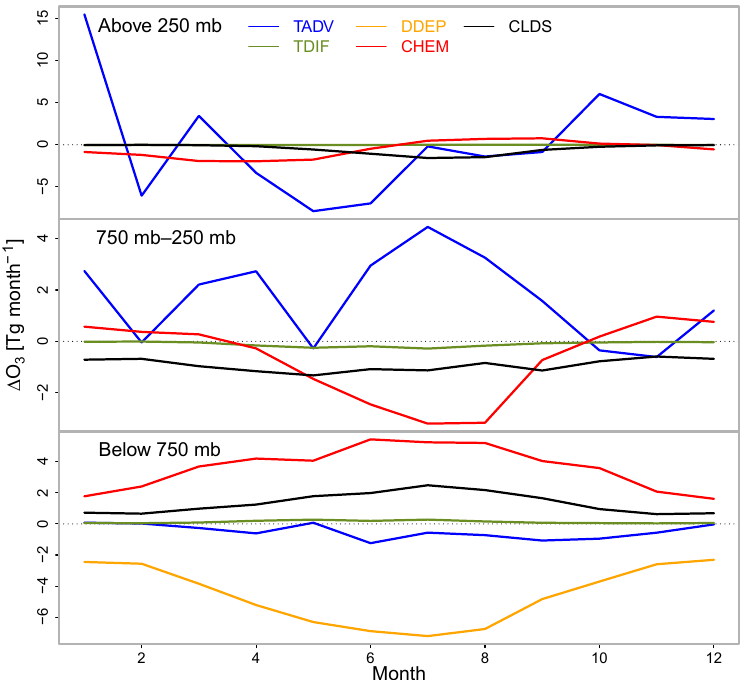
Figure 5. Time series of monthly domain-wide total process analysis contributions to BASE ozone columns in CMAQ layers 1–21 (surface to approximately 750mb), 22–31 (approximately 750–250mb), and 32–35 (approximately 250–50mb). The horizontal and vertical advection and diffusion terms were summed to compute the effects of total advection (TADV) and total diffusion (TDIF),